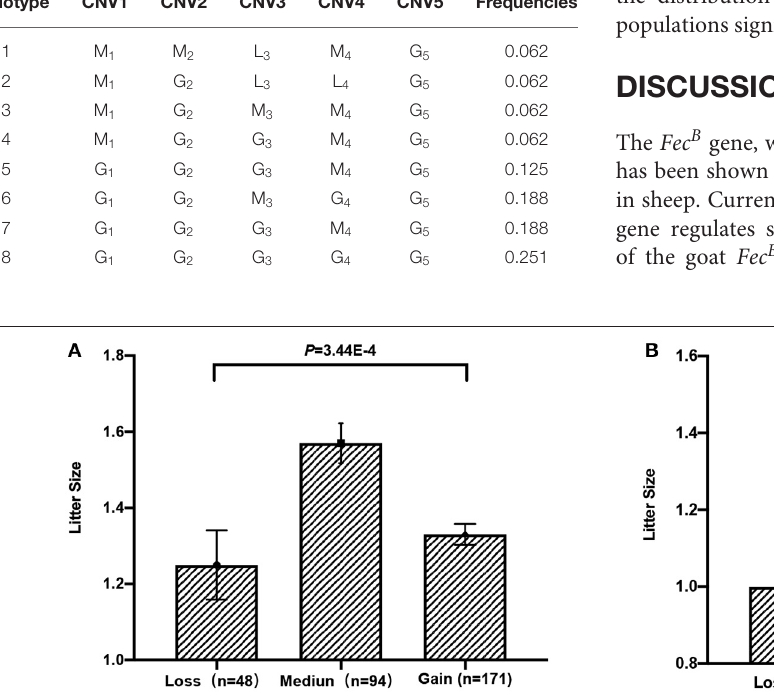
Frontiers in Veterinary Science |